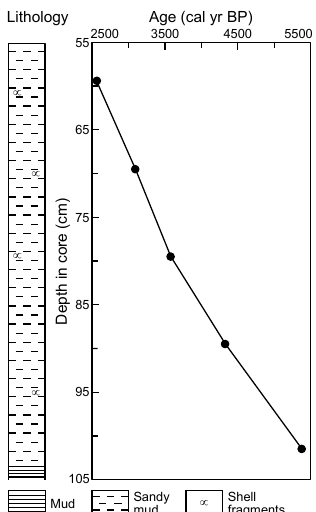
Figure 2. Lithological log and age–depth model of the segment of the HL06 core between 105 and 55cm at core depth (covering the period between 5000 and 3000cal.yrBP). Solid circles represent the mean values of 2 σ ranges of calibrated ages of carbon-reservoir- corrected radiocarbon dates. The carbon reservoir correction factor is 685 ± 21 years, which is the 14 C age of the uppermost 1cm of the core sediments. Modified after Xiao et al.